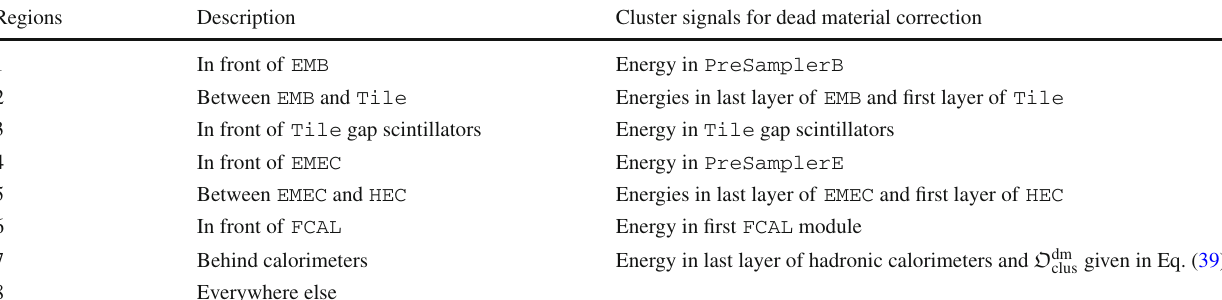
Table2 Overviewofthesignalsusedtocorrectfordeadmateriallosses in the various regions around the ATLAS calorimeters. The numbered regions are shown in Fig. 17. The parameter values used for the dead material correction are extracted from lookup tables. Region 8 com-